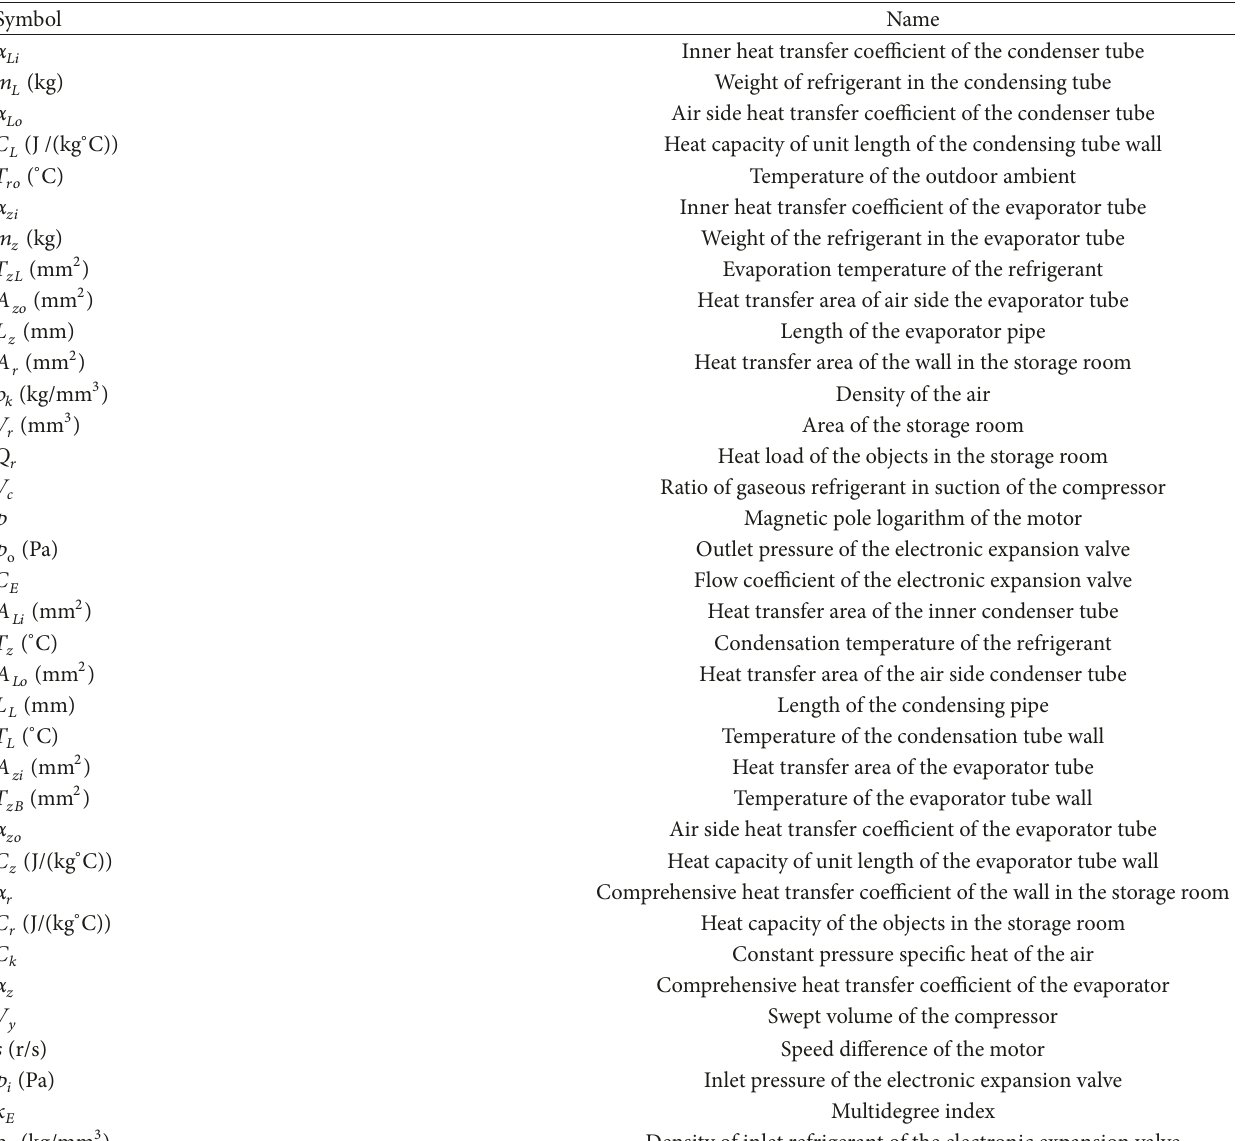
Table 2: Variables and parameters in